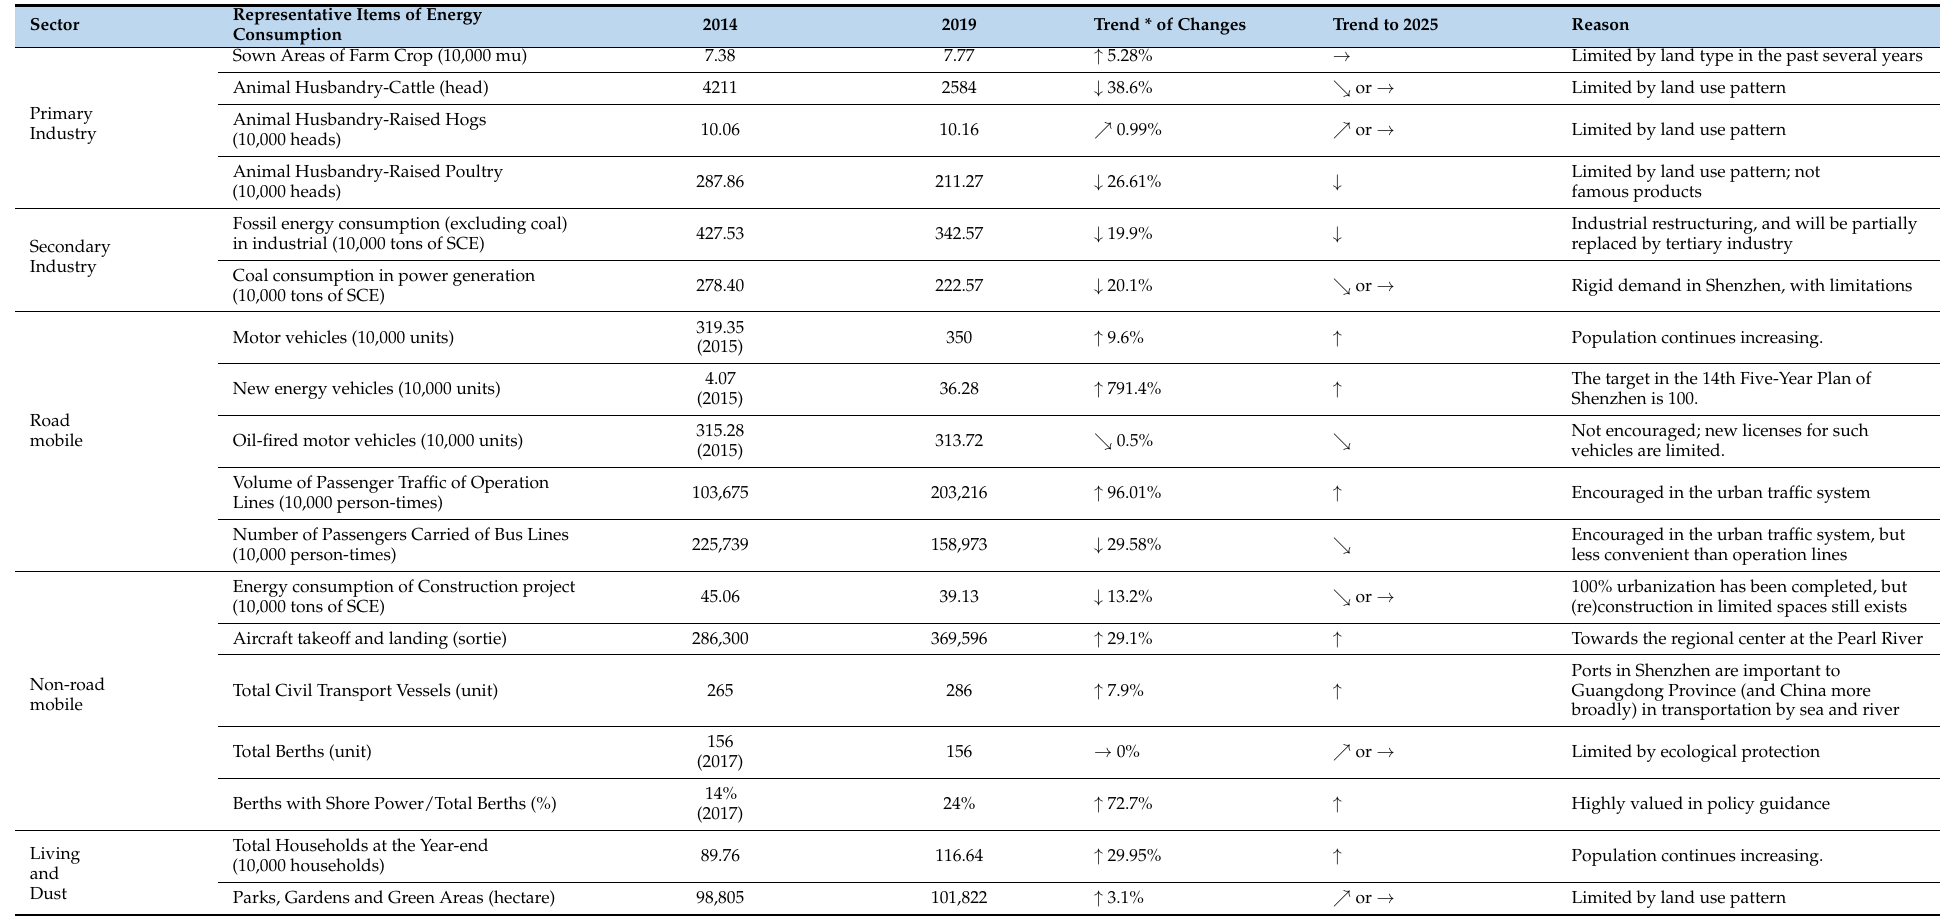
Table 9. Social activities in Shenzhen related to energy